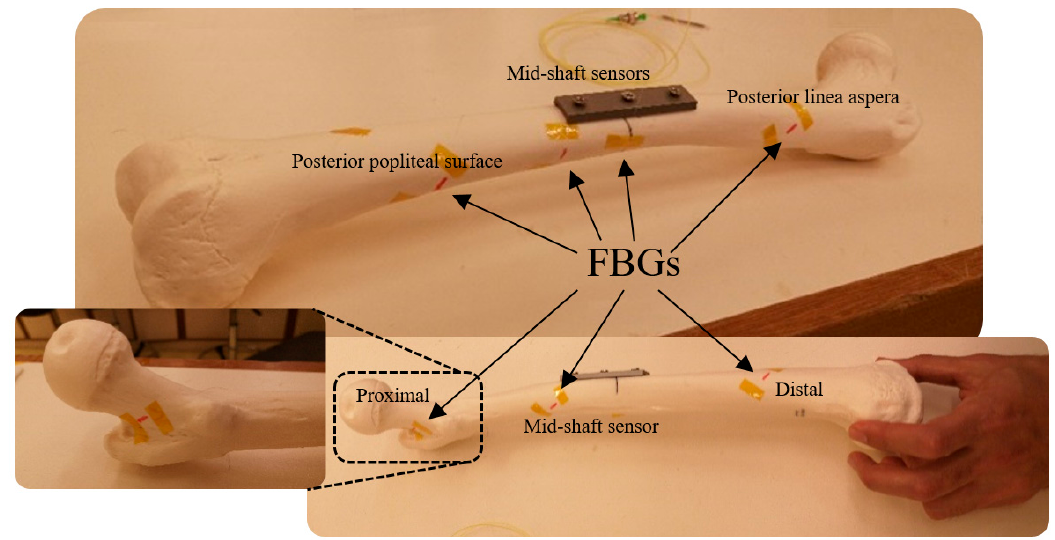
Figure 2. Plated femur sawbones instrumented with seven FBG strain sensors on a coiled FBG array. Table 1. Distance of FBG sensors with respect to the proximal end of the composite femur on each FBG array. FBG Distance of Gratings on the Optical Fibre (cm)